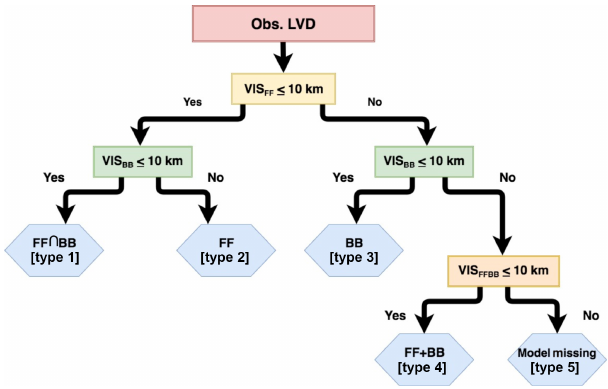
Figure 2. Logical chart for fire (BB), non-fire (FF), or coexisting fire and non-fire (FF + BB) aerosols caused LVDs. “Obs. LVD” is an LVD identified from observation. Then, the modeled visibility from FF (VIS FF ) , BB (VIS BB ) , and FFBB (VIS FFBB ) are used to classify observed LVD into five types. Type 1 LVD represents the cases where either fire or non-fire aerosols alone can cause the observed LVD to occur. Type 2 means that non-fire aerosols are the major contributor to the observed LVD. Type 3 means that fire aerosols are the major contributor to the observed LVD. Type 4 rep- resents the cases where the observed LVD is induced by coexisting fire and non-fire aerosols. The observed LVDs that the model cannot capture are classified as Type